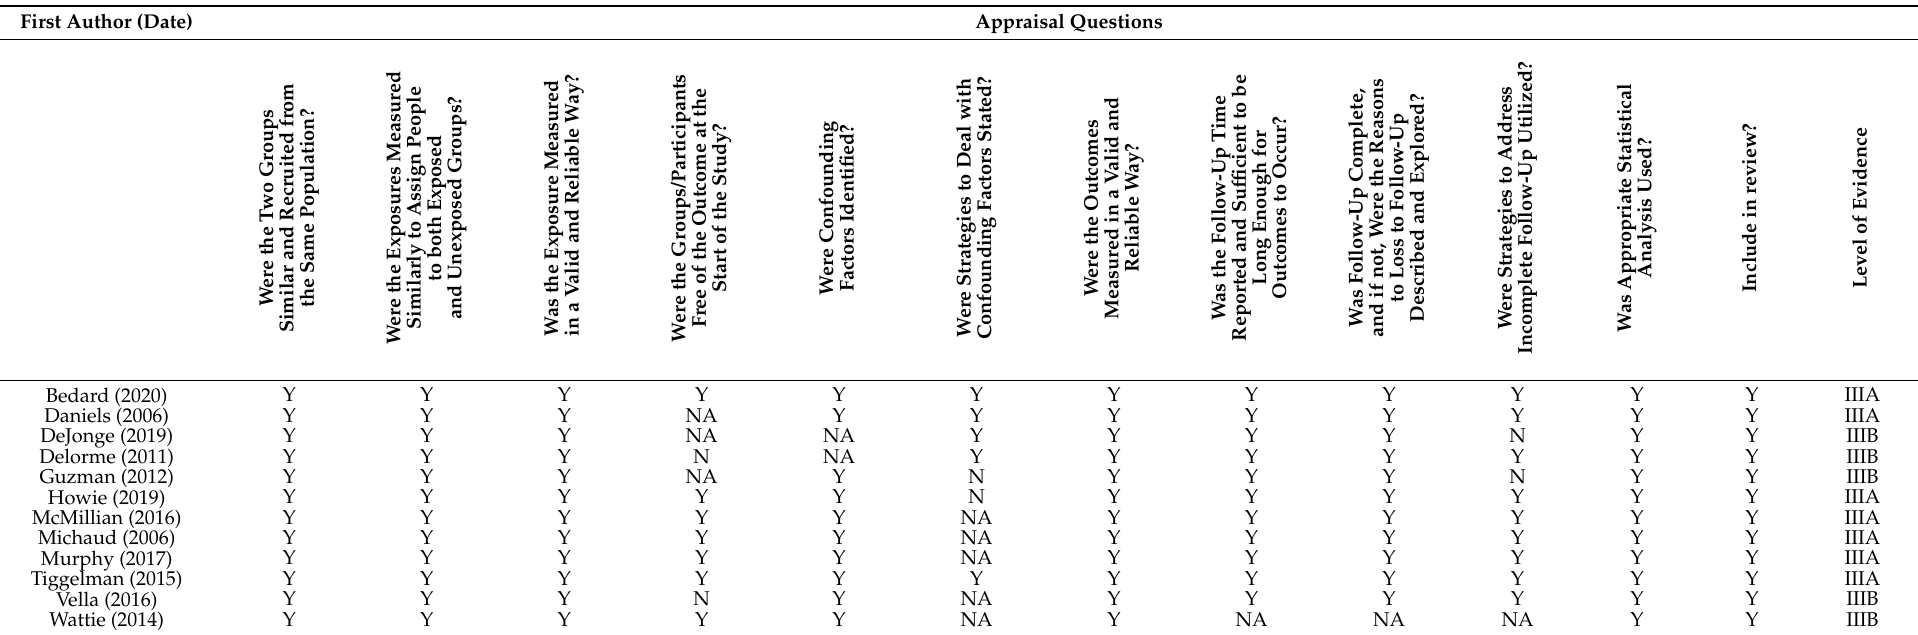
Table A2. Critical appraisal of cohort